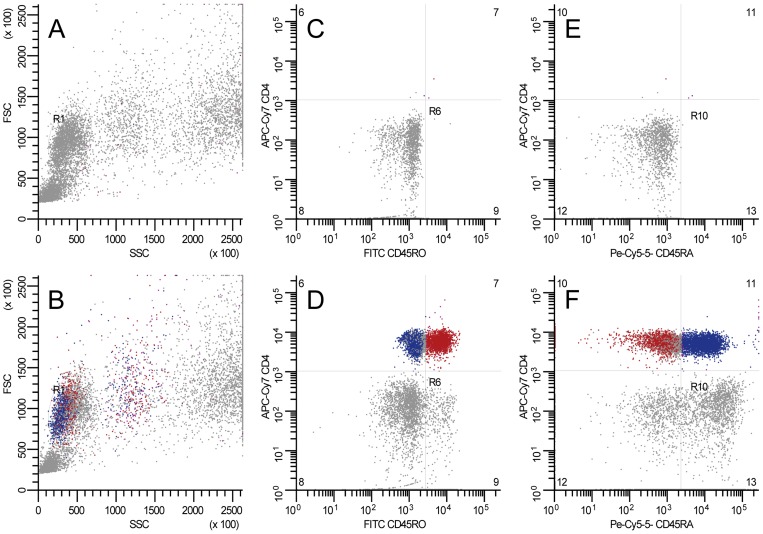
Typical flow cytometric data for lymphocyte, CD4+ memory, and CD4+ naive cell populations.At least 30,000 lymphocytes were evaluated and were gated based on their forward (FCS; X-axis) and side (SCS; Y-axis) scatter (Panels A&B). Memory and naive cell subpopulations were gated by positive surface staining for CD4 (Y-axis, panels C–F); memory cells were gated by positive surface staining for CD45RO (X-axis, panels C&D); naive cells were gated by positive surface staining for CD45RA (X-axis, panels E&F). Typical data from respective isotype controls (Panels A, C, and E) and fluorescently labeled samples (Panels B, D, and F) are shown.